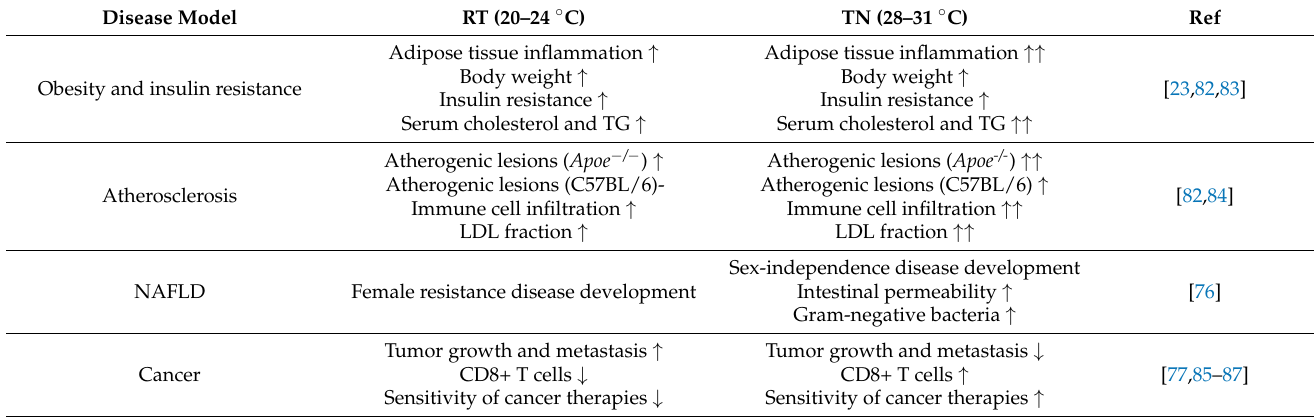
Table 1. Summary of the effects of housing temperature on the phenotypes observed in mice disease